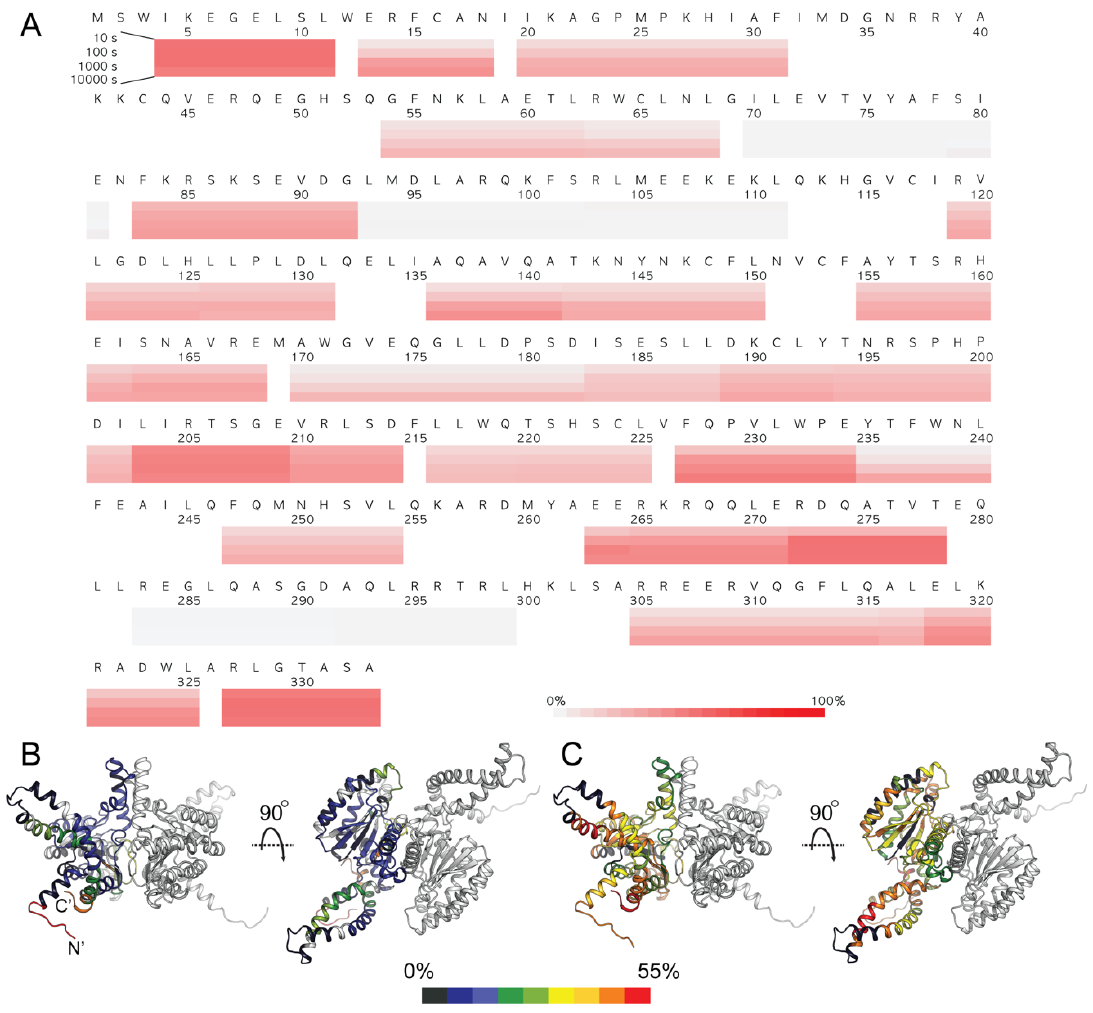
Figure 6. HDX-MS analysis of human DHDDS. ( A ) Deuterium uptake profiles. Incorporation of deuterium at 10, 100, 1000, and 10,000 sec are indicated by color-coded blocks underlining the amino acid sequence. The color legend shows the deuterium uptake levels. ( B,C ) The heat maps at 10 sec ( B ) and 10,000 s ( C ) are overlaid on one monomer of the DHDDS model. The color legend shows the deuterium uptake level. Regions not covered are colored gray.